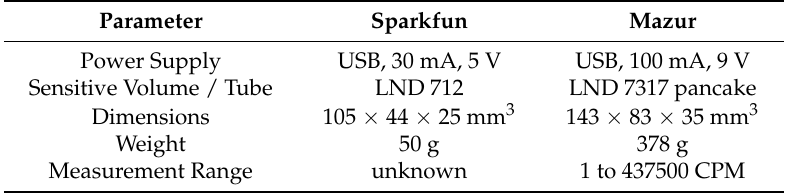
Table 2. GMC characteristics as declared by the manufacturers